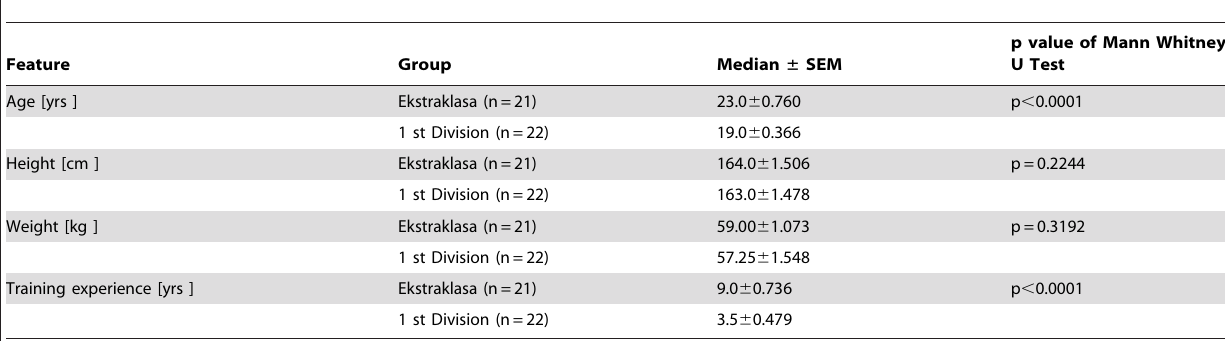
Table 1. Descriptive characteristics of players participating in the study.